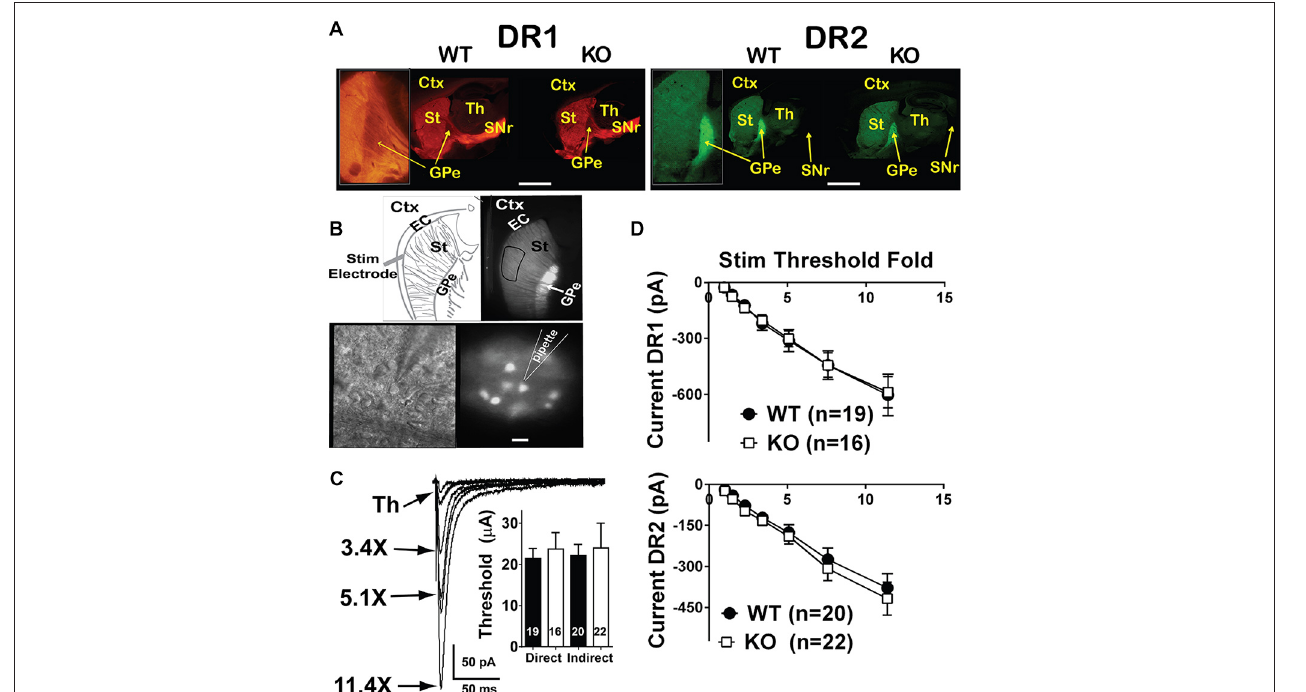
high power infrared differential interference contrast and DOT optics (right) or DR2-EGFP fluorescence (left) images showing the approach of a recording pipette to an EFGP-expressing MSN. Bar = 25 µ m for bottom images and 500 µ m for top images. (C) Traces of evoked EPSCs (eEPSCs) elicited upon current injections onto the EC, and recorded in whole-cell configuration in striatal MSNs. The intensity of the stimulation, expressed as a multiple of the threshold, is connected to the corresponding trace by an arrow. Inset. For I/O recordings, threshold stimulation was required to be below 60 µ A. Under this condition, stimulation threshold was similar between WT and NL1 KO mice. (D) I/O curves for the direct (left) or the indirect (right) pathways are similar between genotypes. Labels: Ctx, cortex; EC, external capsule; St, striatum; Th, thalamus; GPe, globus pallidus externus and SNr, substantia nigra pars reticulata.